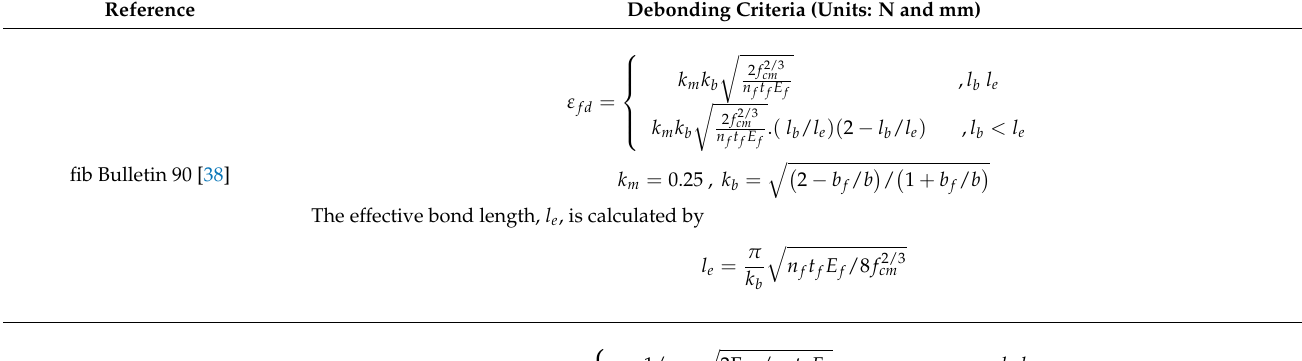
Table 5. Fracture energy-based models given by codes for the prediction of plate end debonding.